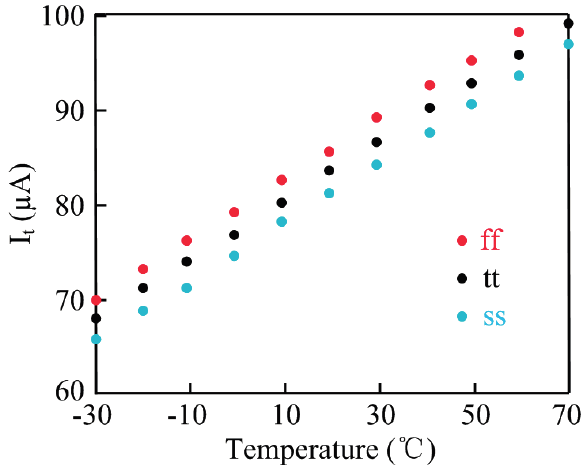
Figure 4. Simulation results of current vs. temperature on different process